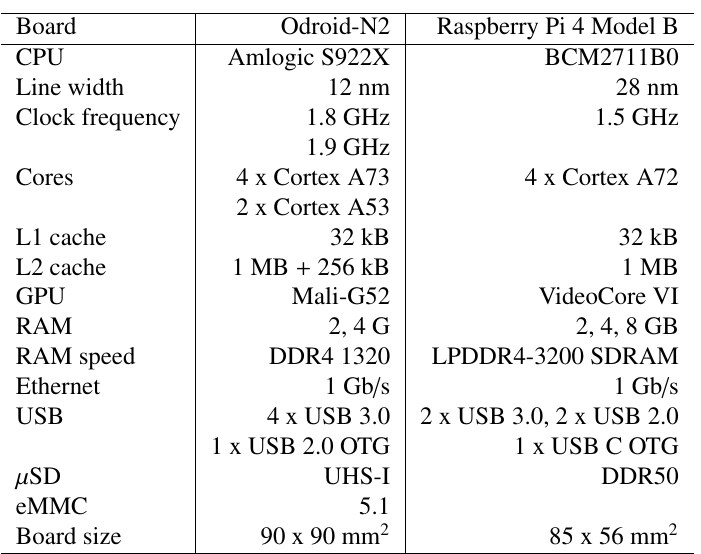
Table 1. Comparison of the Odroid-N2 and the Raspberry Pi 4 Model